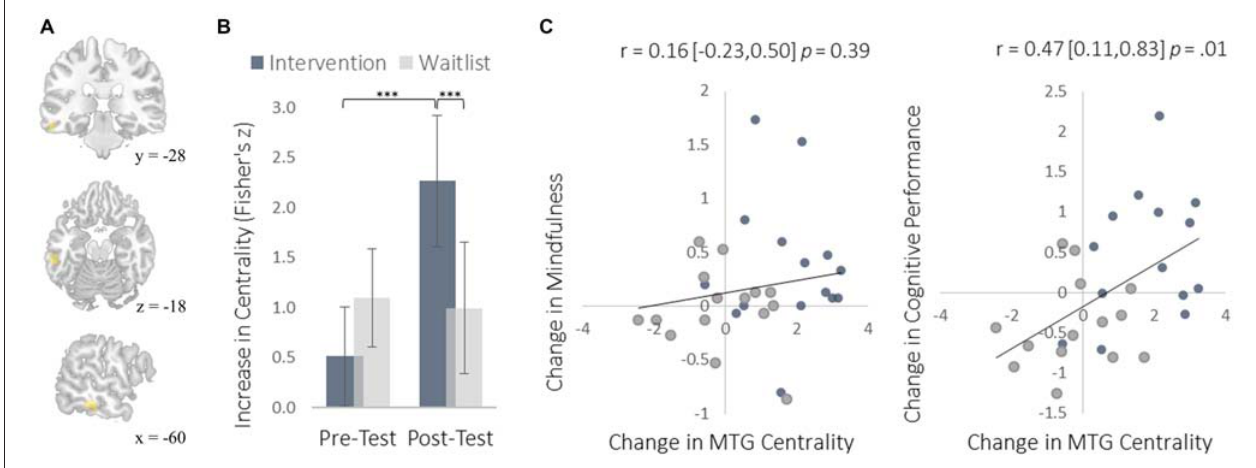
FIGURE 4 | Changes in degree centrality in the MTG. (A) The location of significant clusters in the left MTG demonstrating increased degree centrality (MNI peak-coordinate: − 60, − 32, − 16). (B) Mean degree centrality values within the MTG cluster for the intervention and waitlist groups at pre-testing and post-testing. (C) Scatterplots correlating changes in MTG degree centrality with changes in mindfulness and changes in cognitive performance from pre-testing to post-testing. Error bars and brackets represent 95% confidence intervals. ∗∗∗ p < 0.001. N = 30.